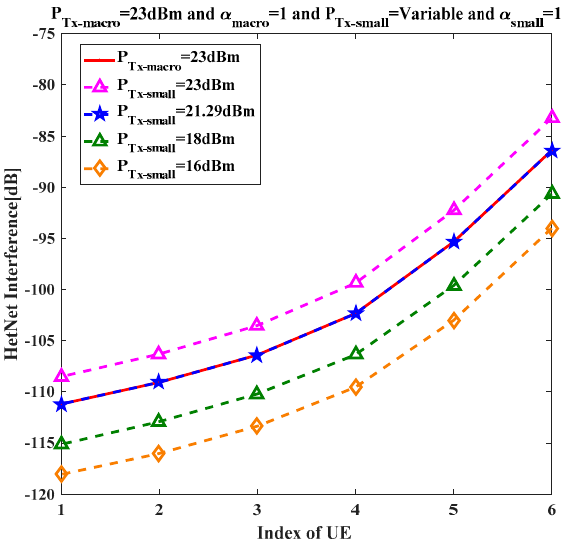
Figure17. Interferencecomparisonasafunctionof P max Figure 17. Interference comparison as a function of P max in the uniform macro cell and HetNet deployments.